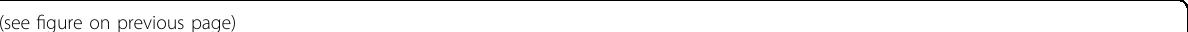
Fig. 4 Exosomal miR-21-5p induces angiogenesis and vascular permeability by regulating KRIT1. A Expression of KRIT1 in HUVECs treated with miR-21-5p mimics, miR-21-5p inhibitor, SW480/mock exosomes, SW480/miR-21-5p exosomes, SW620/NC exosomes, SW620/zip-miR-21-5p exosomes, SW480/mock exosomes, SW480/miR-21-5p exosomes, SW480/miR-21-5p exosomes + KRIT1, SW620/NC exosomes, SW620/zip-miR-21-5p exosomes or SW620/zip-miR-21-5p exosomes + siKRIT1 by Western blot. Expression levels were normalized to β -actin. B Effect of SW480/mock exosomes, SW480/miR-21-5p exosomes, SW480/miR-21-5p exosomes + KRIT1, SW620/NC exosomes, SW620/zip-miR-21-5p exosomes and SW620/zip- miR-21-5p exosomes + siKRIT1 on the proliferation of HUVECs. Mean ± SEM are provided ( n = 3). C Effect of SW480/mock exosomes, SW480/miR-21- 5p exosomes, SW480/miR-21-5p exosomes + KRIT1, SW620/NC exosomes, SW620/zip-miR-21-5p exosomes and SW620/zip-miR-21-5p exosomes + siKRIT1 on the migration of HUVECs by Boyden chamber. Scale bars represent 50 µm. Mean ± SEM are provided ( n = 3). D Effect of SW480/mock exosomes, SW480/miR-21-5p exosomes, SW480/miR-21-5p exosomes + KRIT1, SW620/NC exosomes, SW620/zip-miR-21-5p exosomes and SW620/zip- miR-21-5p exosomes + siKRIT1 on tube formation ability of HUVECs. Scale bars represent 50 µm. Mean ± SEM are provided ( n = 3). E Effect of SW480/ mock exosomes, SW480/miR-21-5p exosomes, SW480/miR-21-5p exosomes + KRIT1, SW620/NC exosomes, SW620/zip-miR-21-5p exosomes and SW620/zip-miR-21-5p exosomes + siKRIT1 on the permeability of the HUVEC monolayers to rhodamine-dextran by in vitro permeability assay. Mean ± SEM are provided ( n = 3). F The number of GFP + CRC cells invaded through the HUVEC monolayers pre-treated with SW480/mock exosomes, SW480/miR-21-5p exosomes, SW480/miR-21-5p exosomes + KRIT1, SW620/NC exosomes, SW620/zip-miR-21-5p exosomes or SW620/zip-miR-21-5p exosomes + siKRIT1. Scale bars represent 50 µm. Mean ± SEM are provided ( n = 3). * P < 0.05, ** P < 0.01, *** P <